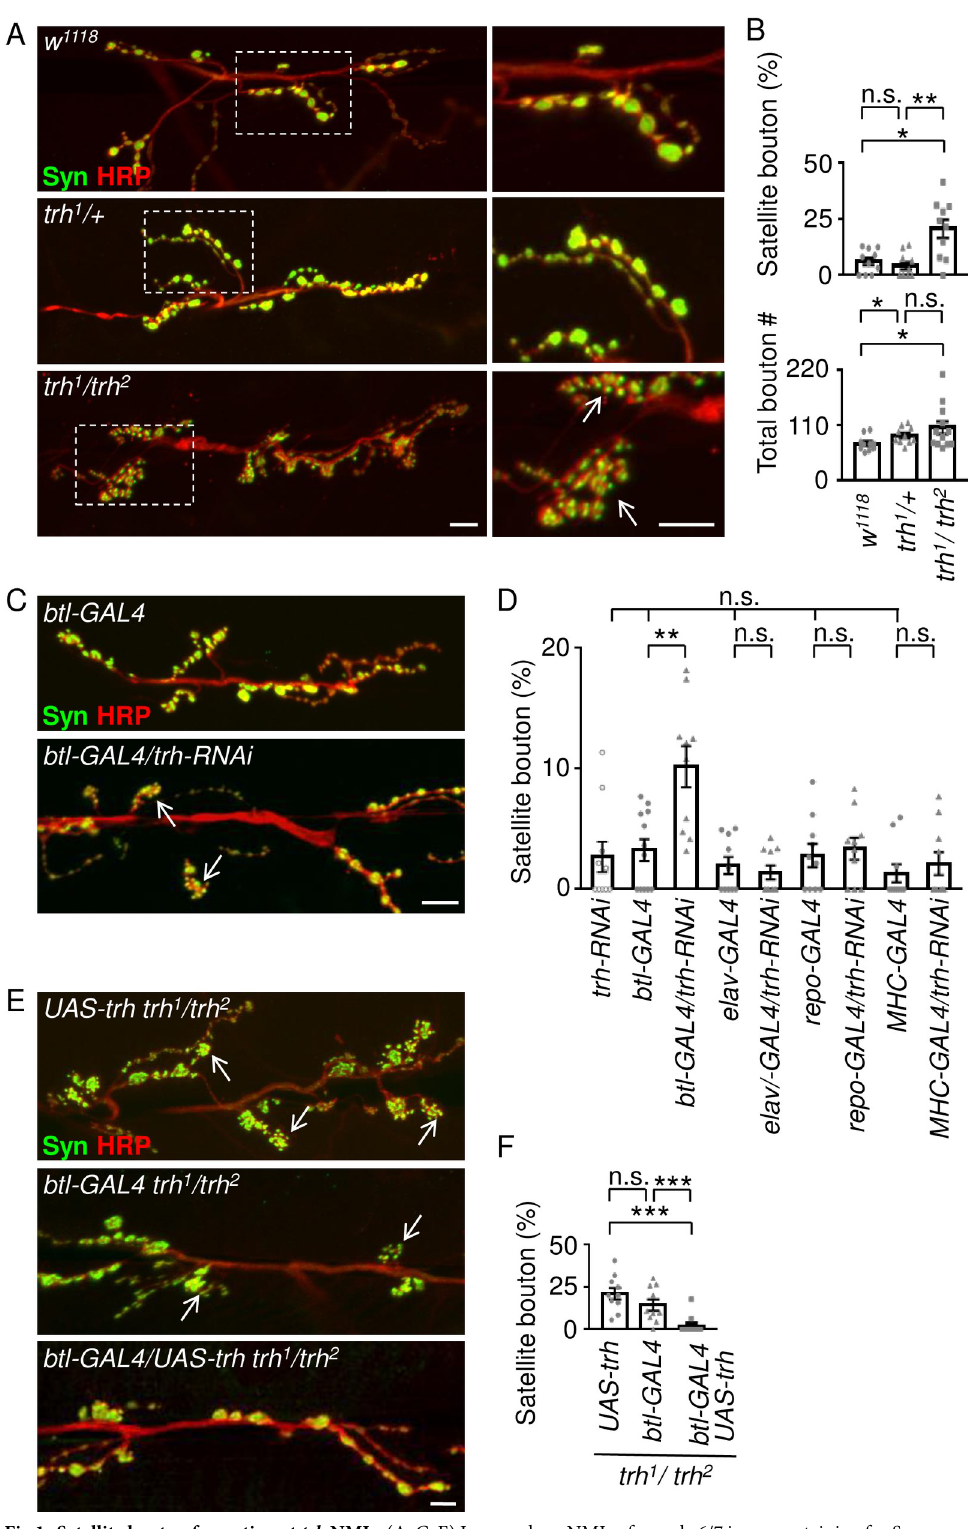
Fig 1. Satellite bouton formation at trh NMJs. (A, C, E) Images show NMJs of muscle 6/7 immunostaining for Syn (green) and HRP (red) in w 1118 , trh 1 /+ , and trh 1 /trh 2 (A), btl-GAL4 and btl - GAL4/trh-RNAi (C), and UAS-trh trh 1 /trh 2 , btl-GAL4 trh 1 /trh 2 , and btl-GAL4/UAS-trh trh 1 /trh 2 (E). Dashed squares in (A) are enlarged in right panels with white